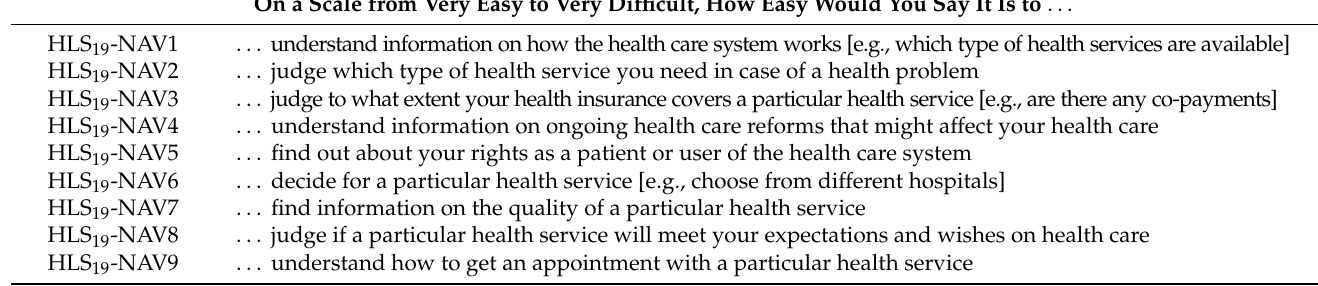
Table 1. The HLS 19 -NAV